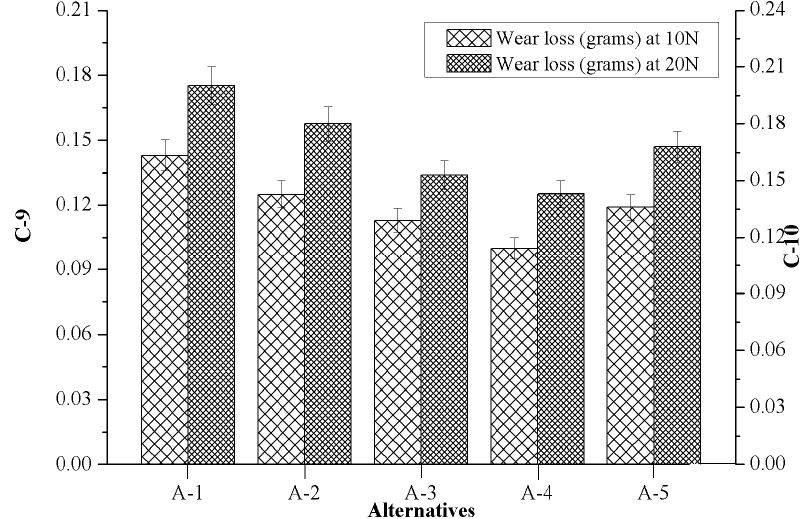
Figure 7. Variation of criterion-9 and criterion-10 with the values of alternatives.